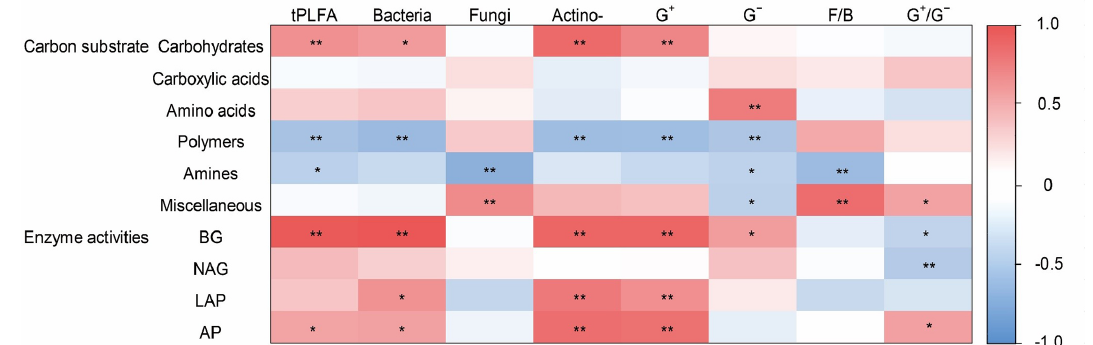
Figure 5. The heatmap of the Pearson’s correlation coefficients between the use of individual substrates and microbial PLFAs and soil enzyme activities. Note the abbreviations of the variables: actino-, actinomycetes; F / B, fungi to bacteria ratio; G + , Gram-positive bacteria; G − , Gram-negative bacteria; G + / G − , Gram-positive bacteria to Gram-negative bacteria ratio. BG, β -1, 4-glucosidase; NAG, β -1,4-N-